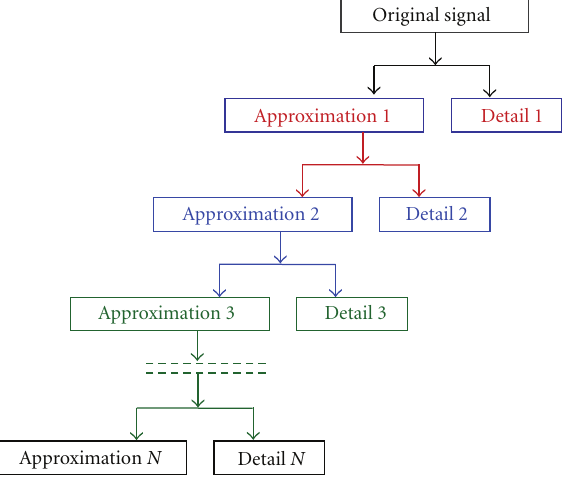
Figure 2: Schematic representation of wavelet multi-resolution analysis showing the decomposition of the original signal into N levels of decomposition and details